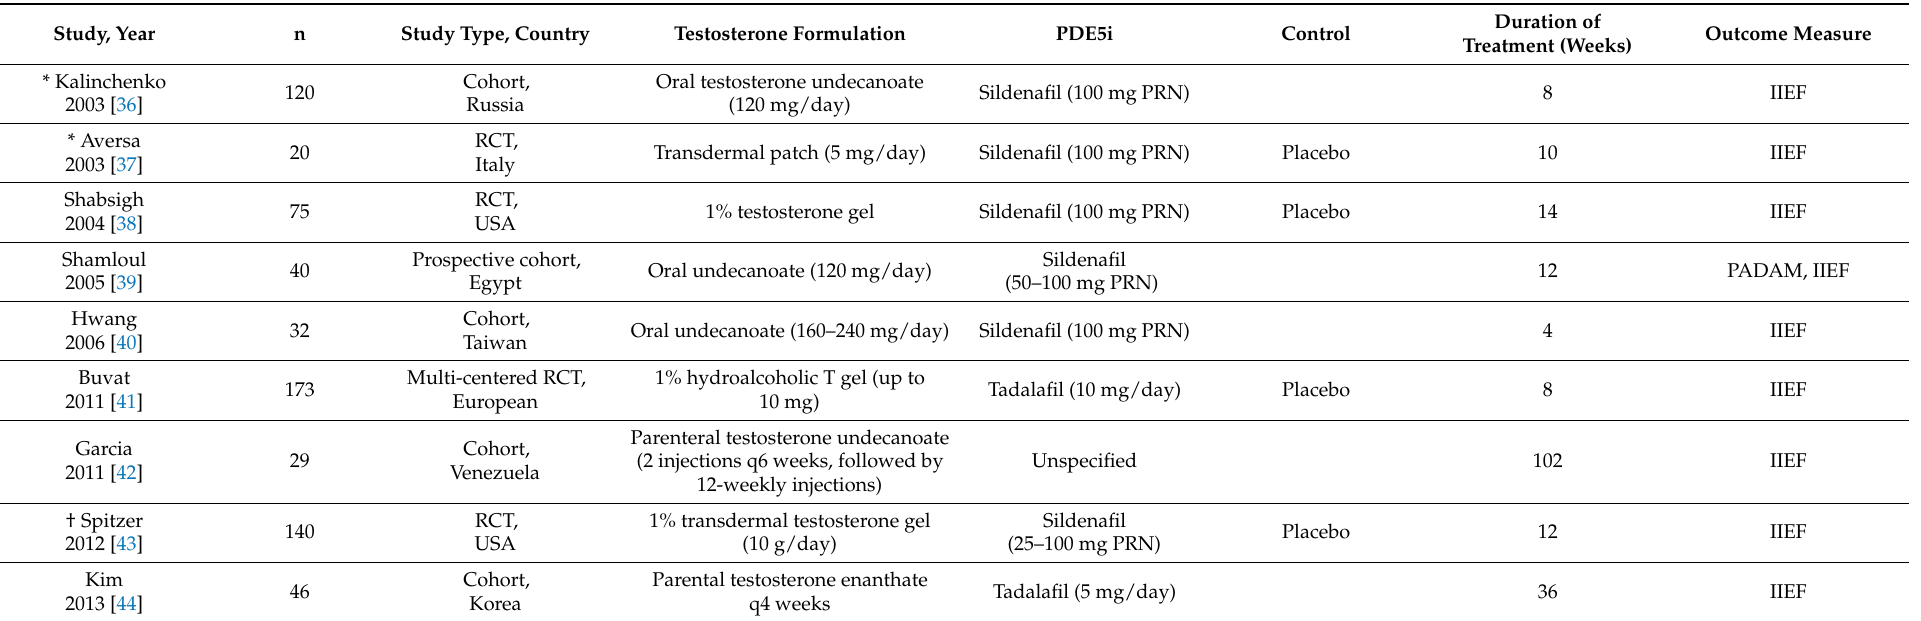
Table 1. Summary of included studies in hypogonadal men with inadequate response to